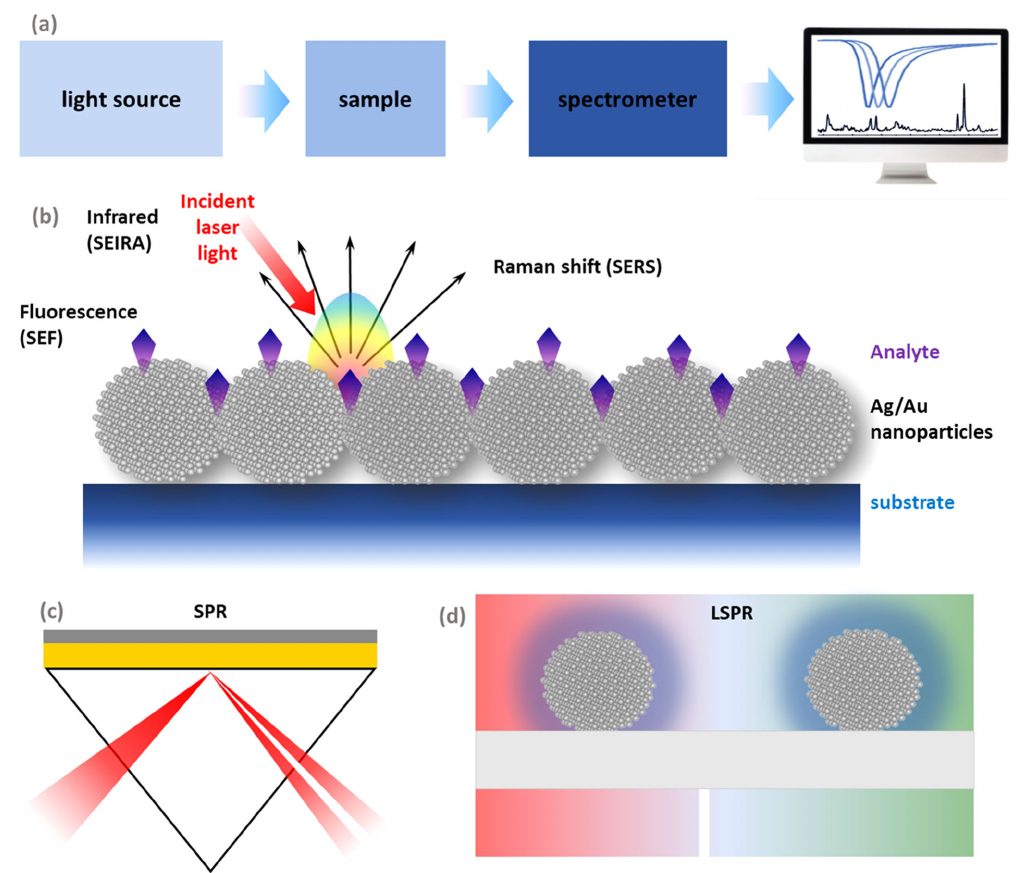
Figure 3. The basic principles of plasmonic ‐ based detection methods. ( a ) General scheme of a plas ‐ monic ‐ based sensor; ( b ) SERS, SEF, and SEIRA; ( c ) SPR; ( d ) LSPR. plasmonic-based sensor; ( b ) SERS, SEF, and SEIRA; ( c ) SPR; ( d )